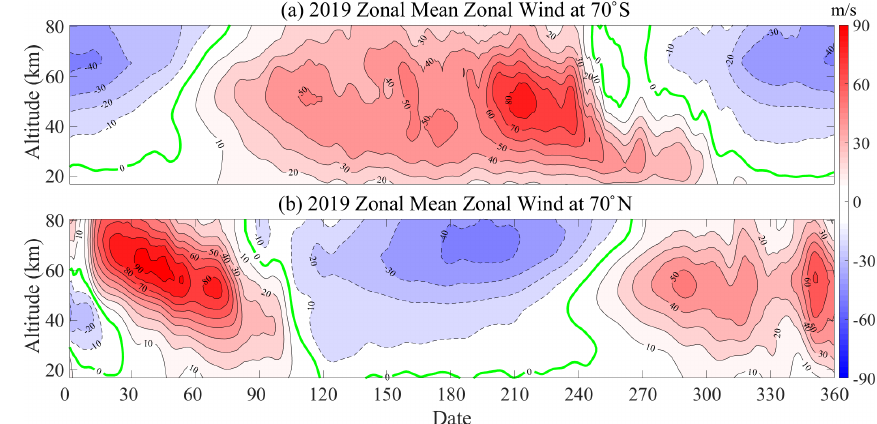
Figure 2. The zonal mean zonal wind variations of (a) 70 ◦ S and (b) 70 ◦ N during 2019. The dashed lines represent eastward wind; the solid black lines represent westward wind; and the solid green line is 0m/s. The date indicates the day of the year.